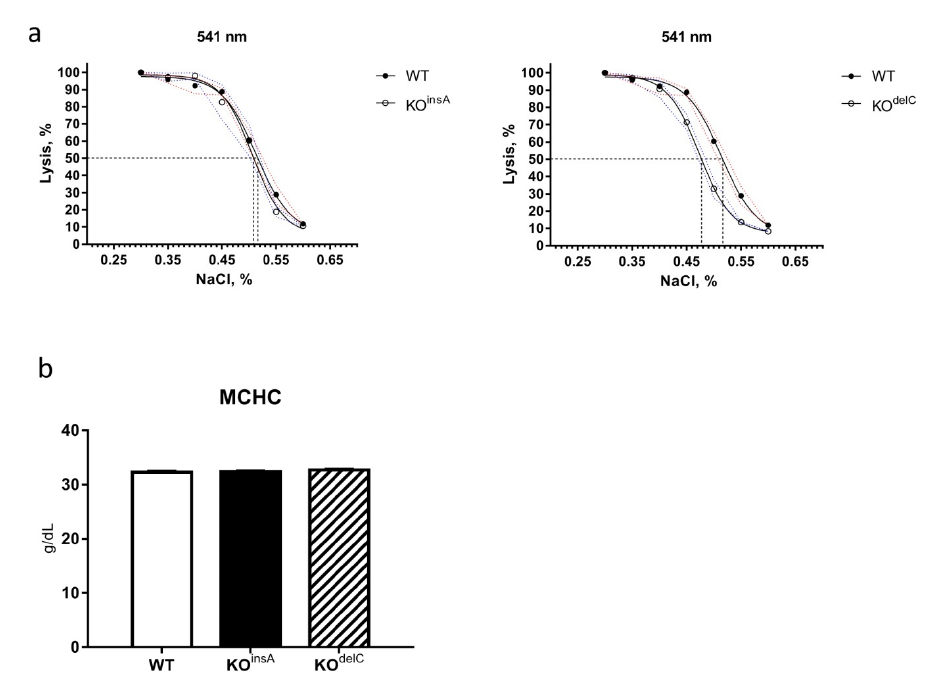
Figure 2. Comparative osmotic fragility test (OFT) and mean corpuscular hemoglobin concentration (MCHC) analysis of WT and TAAR9-KO rats. ( a ) Differences in the hemolysis of red blood cells (RBC) at different concentrations of NaCl are detectable only on KO delC strain. Evaluation results of 50% lysis concentration point: WT= 0.518, KO insA = 0.509, KO delC = 0.479; n = 5 per group ( b ) No alterations in mean corpuscular hemoglobin concentration (MCHC) between TAAR-KO and WT animals; n = 7 per group. Data are mean ± SEM.